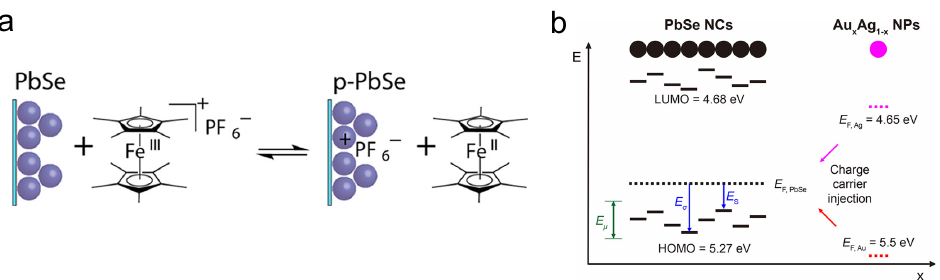
Figure 9. Remote doping mechanisms: ( a ) Illustration of PbSe CQD remote doping by redox buffer. Reprinted with permission from [71]. Copyright 2012 American Chemical Society. ( b ) Illustration of PbSe CQD remote doping by Au x Ag 1 − x NPs. Reprinted with permission from [76]. Copyright 2018 American Chemical